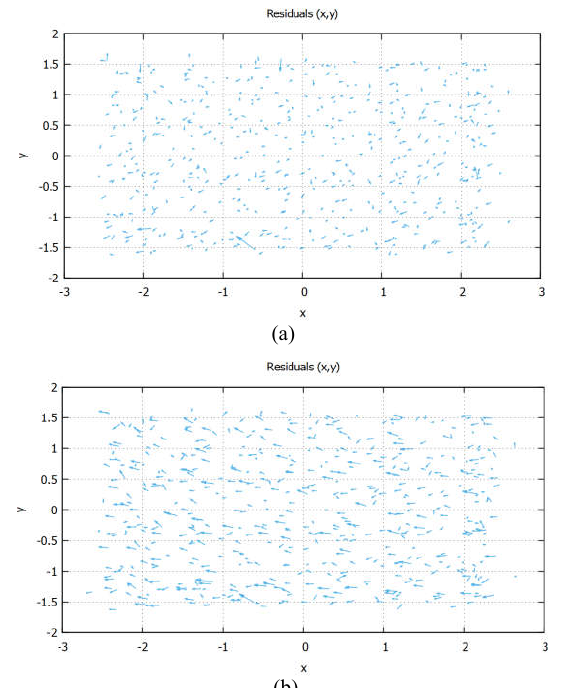
(b) Figure 10. Residuals in the image coordinates of two bands when using the IOPs estimated by the gap-dependent model: (a) Band 20, sensor I and; (b) Band 5, sensor